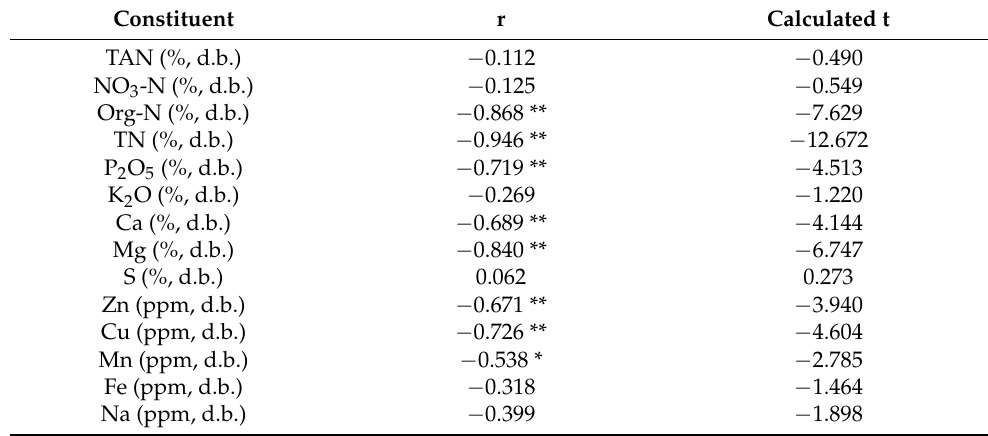
Table 4. Results of linear correlation analysis of concentrations of major and minor plant nutrients with respect to C:N (r = correlation coefficient).